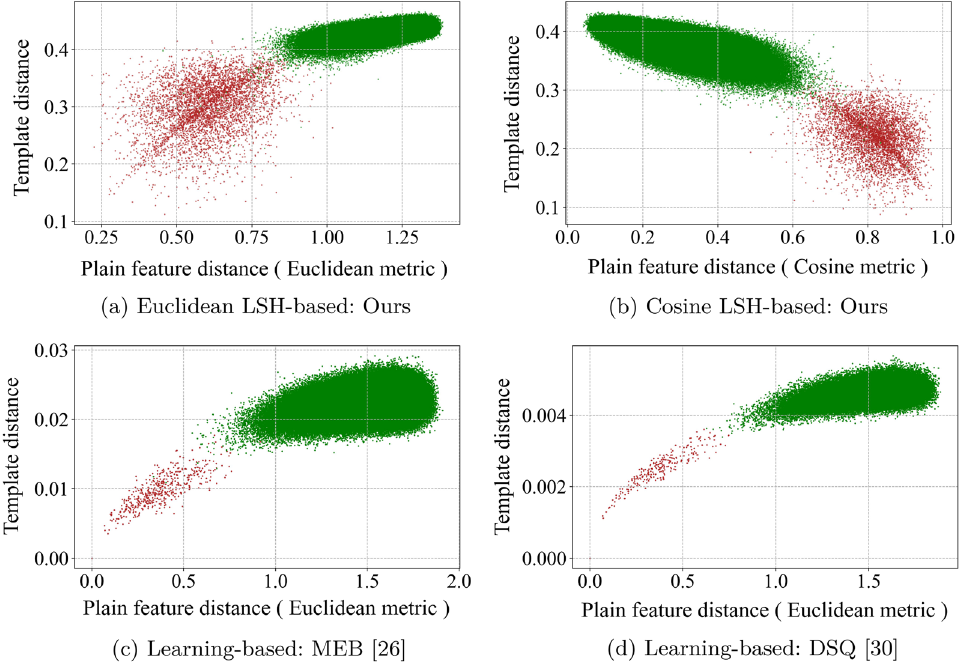
Fig. 11 The relationship between plain feature distance and template distance of different BTP schemes. Here, “red” point denotes intra-class. The “green” point denotes